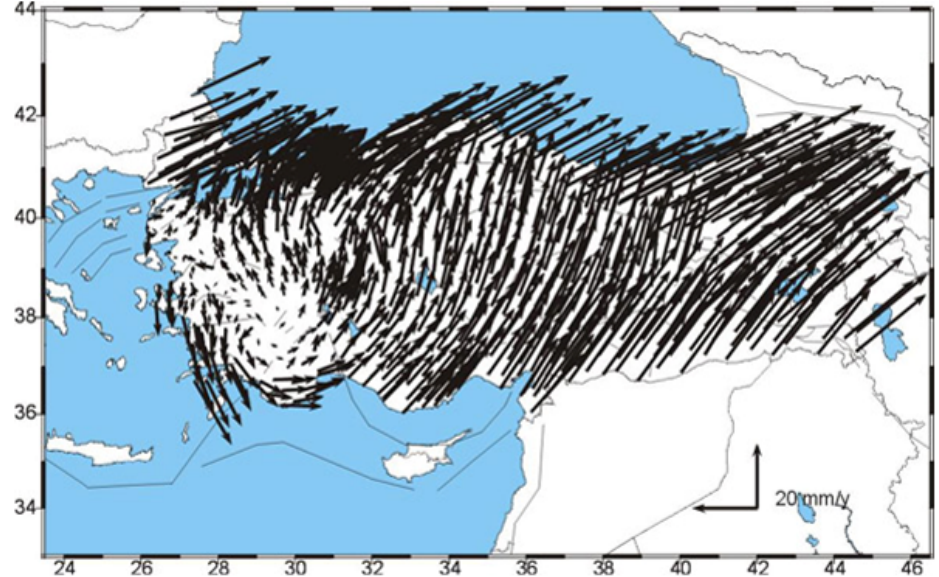
Fig. 3a. Horizontal velocity vectors of the stations within the TUTGA network estimated using GPS observations (Ayhan et al., 2001b).